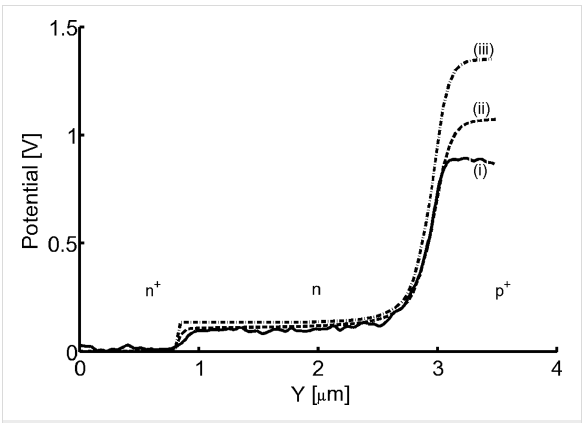
Figure 5: Line section of UHV KPFM (i) measurements [20], (ii) simu- lated, and (iii) theoretical potential distribution of InP(100) p + nn + junc- tion. The measurements were performed at single pass with cantilever first resonance amplitude of 3 nm with a minimum distance of 0.5 nm. The simulation was performed using the following probe geometry: R = 30 nm , β =